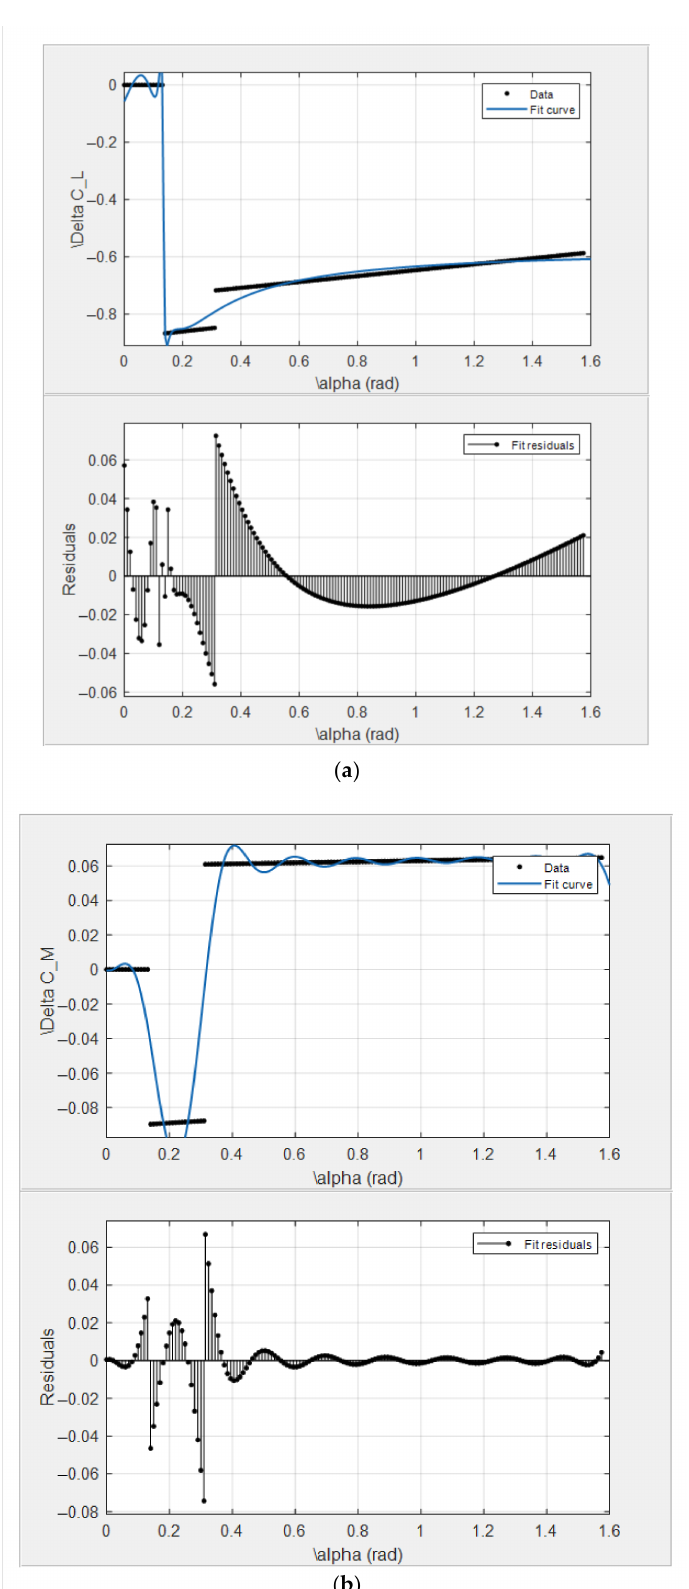
Figure 5. The original data points, fitting curves and residual analysis in the fitting process, cal- culated by using the Residual Analyzer. ( a ) The fitting process and residual analysis of ∆ CL dis- played in Residual Analyzer; ( b ) The fitting process and residual analysis of ∆ CM displayed in Residual